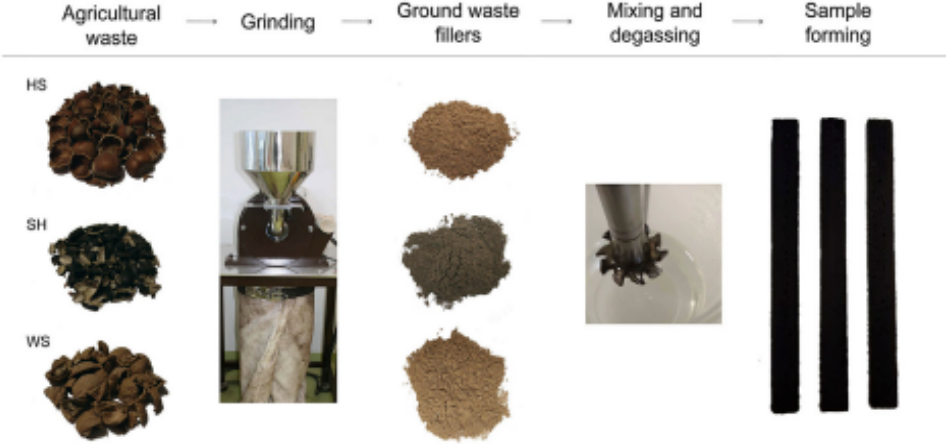
Figure 2. Preparation of epoxy-based natural fibers composites [87] (Reprinted/adapted with per- mission from Elsevier Ref.5457271400523 Copyright 2019).